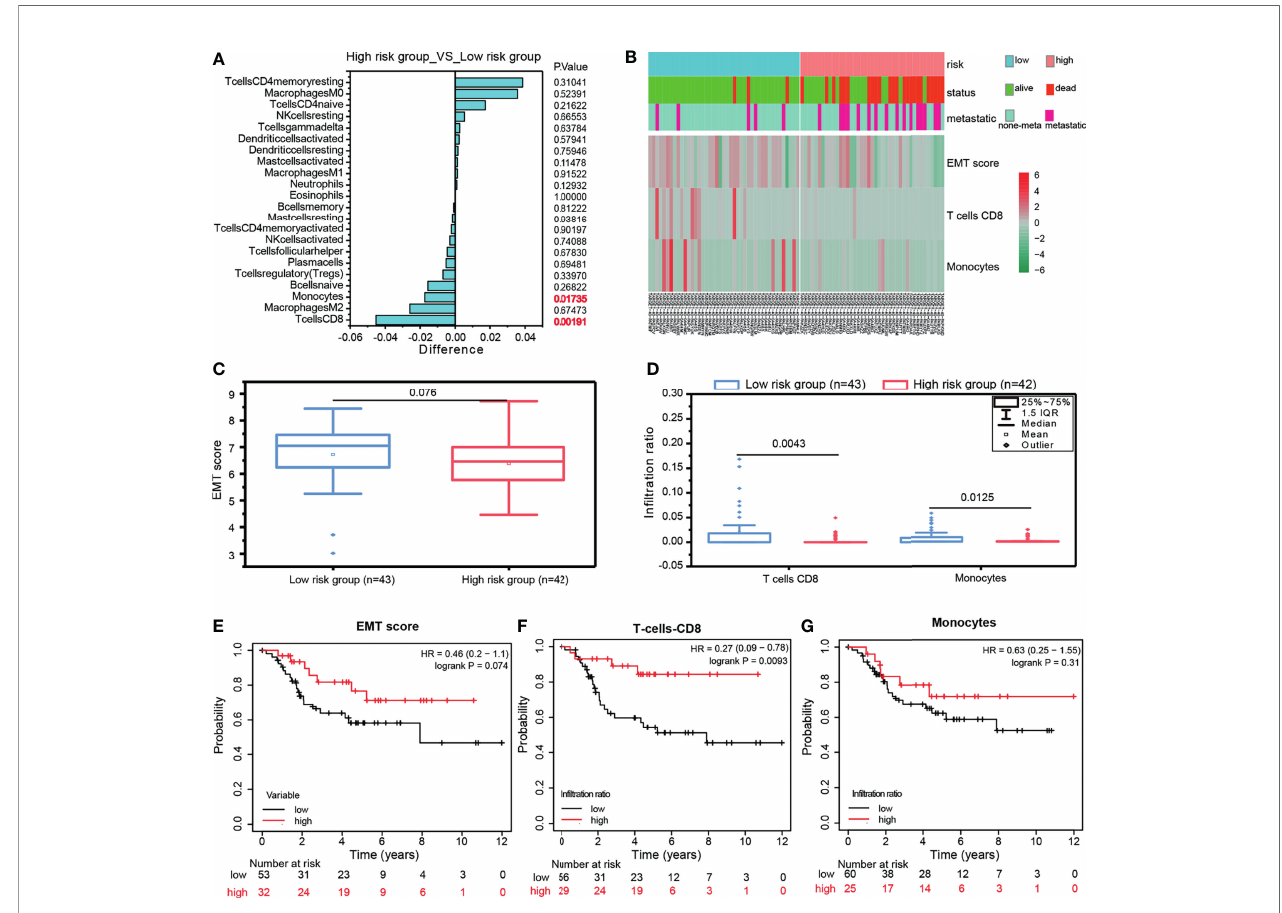
FIGURE 7 | (A) Compare the in fi ltration abundance of immune cells between the high-risk group and low-risk group of the 10-GPCRs model, Differences < 0 indicates that the immune cells were more enriched in the low-risk group. (B) The heatmap showed the relationship among the risk grouping with the patient status, metastasis, EMT Score, T cell CD8, and monocyte in fi ltration abundance. (C) The comparison of EMTscore between the low-risk group and high-risk group. (D) The comparison of CD8 T-cell and monocytes ’ in fi ltration between the low-risk group and high-risk group. (E – G) The survival curves of EMT score, T-cell CD8, and